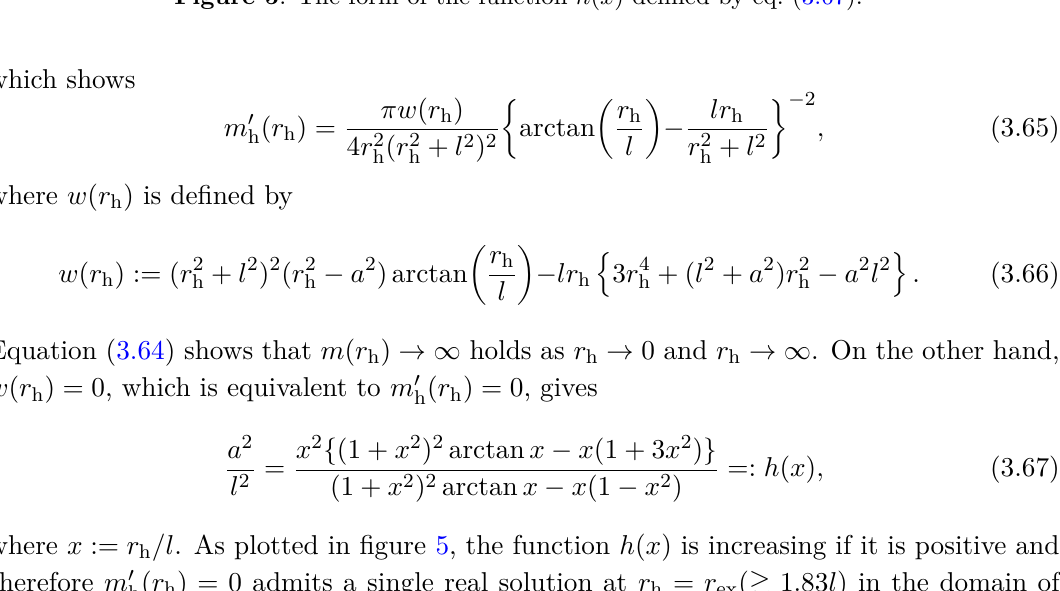
Figure 5 . The form of the function h ( x ) defined by eq.